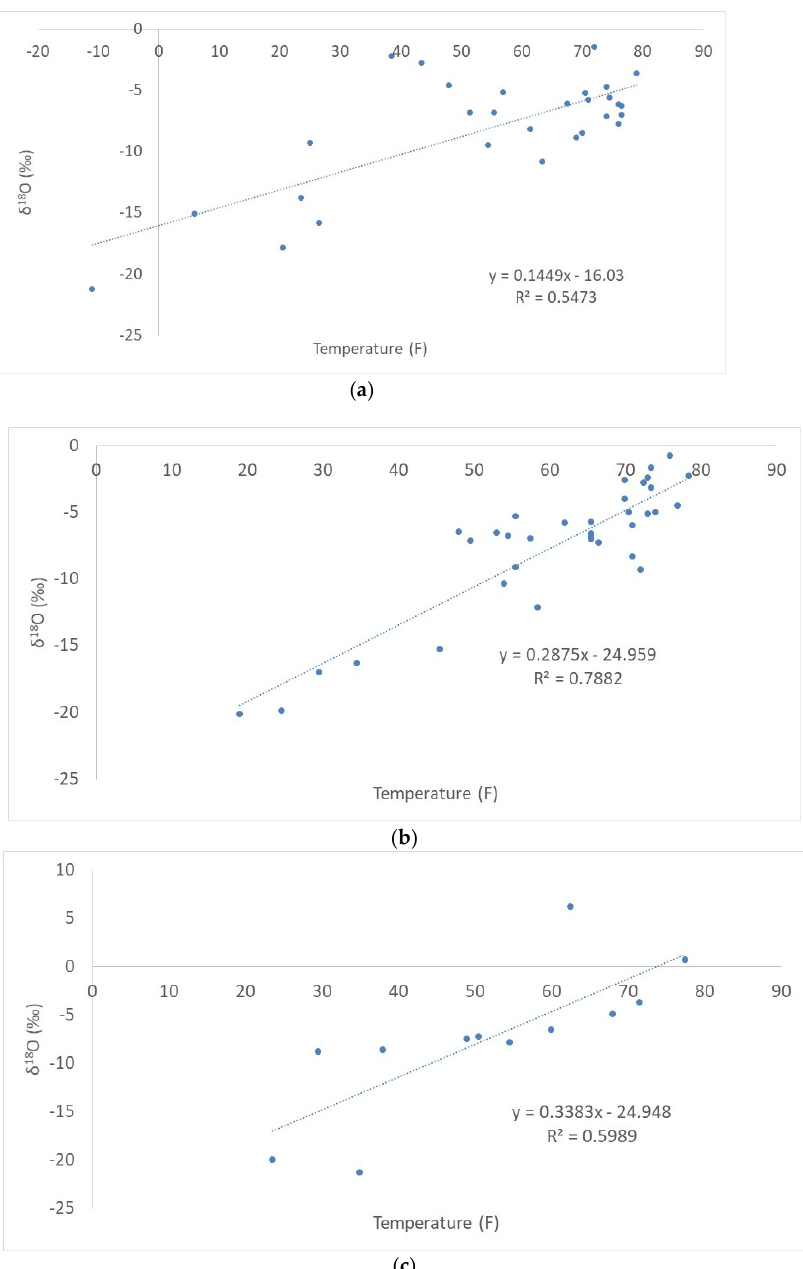
15 of 21 Figure 5. Two-component hydrograph separation for the three sites. GW stands for groundwater. The y-axis is the ratio of component assuming total volume is one. ( a ) Waseca site; ( b ) Tracy site; ( c ) Beresford site . At the Tracy site, lysimeter isotopic signatures were used to represent the vadose zone component based on the interpretation of LMWL in Figure 5b. The first attempt did not include vadose zone soil water and we attempted to partition out groundwater and tile drain flow. However, on most of the days, the river water had an isotopic signature lighter than both phreatic zone sources (Figure 5b), where vadose zone soil water became one of the components. On days when groundwater had a more significant impact on